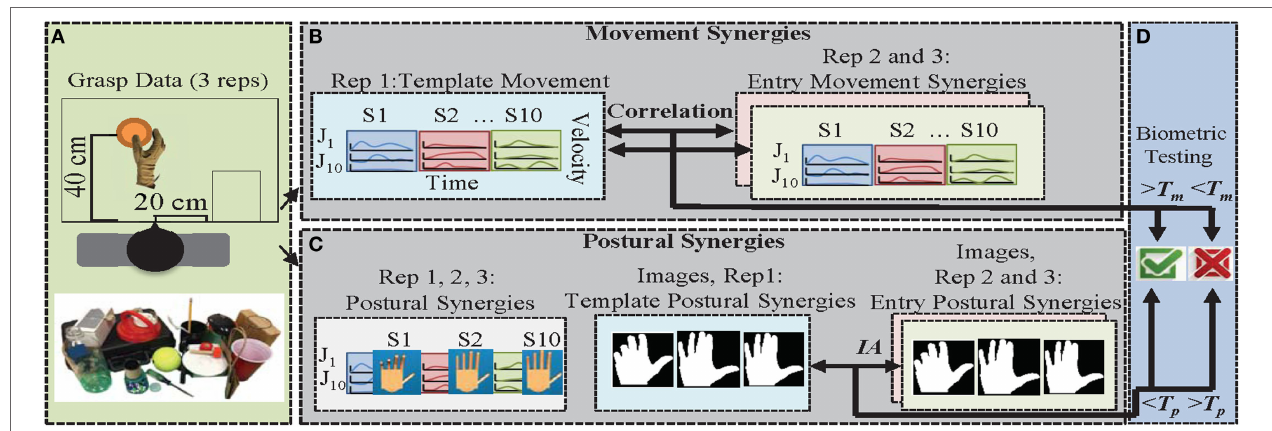
FigUre 1 | Procedure overview for movement synergies and postural synergies as biometrics . (a) Twenty-five objects were grasped with three repetitions each. (B) Movement synergies (S1, … , S10) were extracted from glove data for 10 joints (J1, … , J10) from repetition 1. Movement synergies extracted from repetitions 2 and 3 were used as entry attempts. (c) Immediately after grasp data collection, end position of the movement synergies (derived from repetitions 1–3) were determined and displayed on a virtual hand model. Subjects mimicked these postures and images were taken. Repetition 1 of images was used as a template, and repetitions 2 and 3 of images were used as entry attempts. (D) In order to gain access to the system, the correlation between entry and template movement synergies has to be greater than T m . For postural synergies, the error between entry and template postural synergy images has to be less than T p